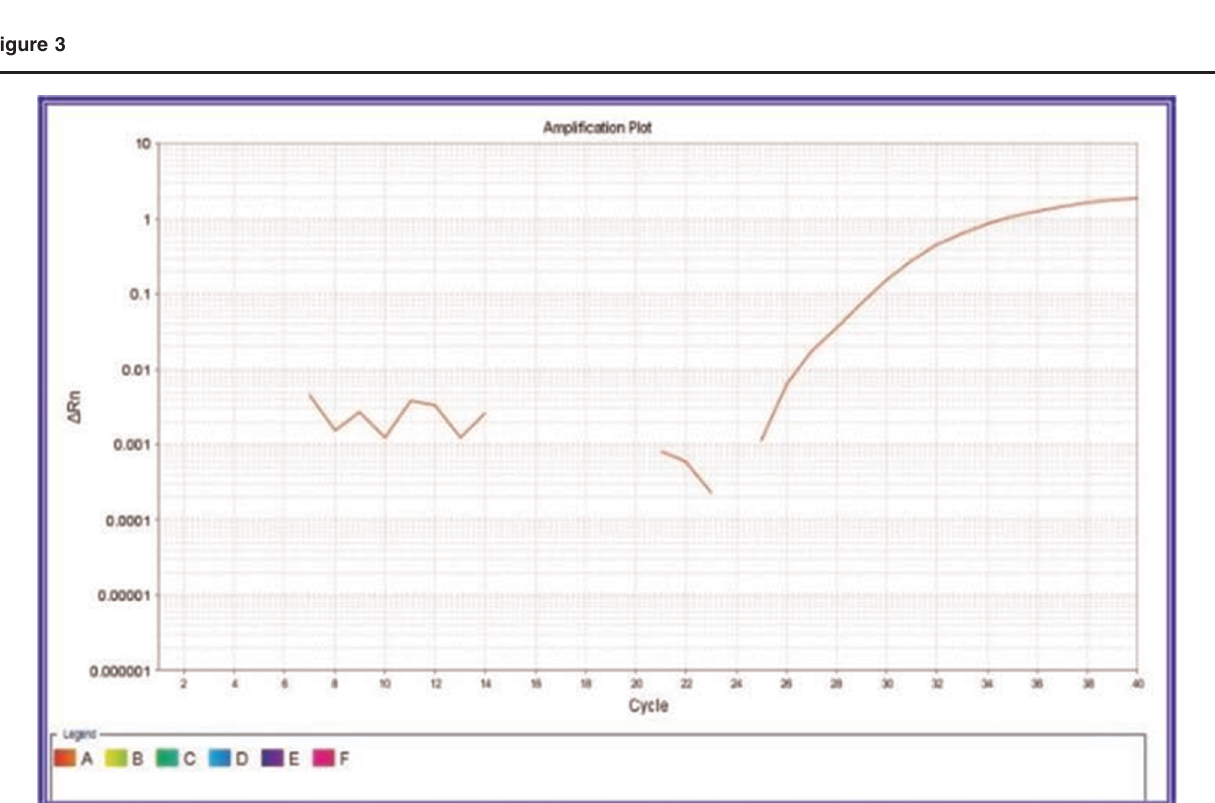
Positive result curve shows